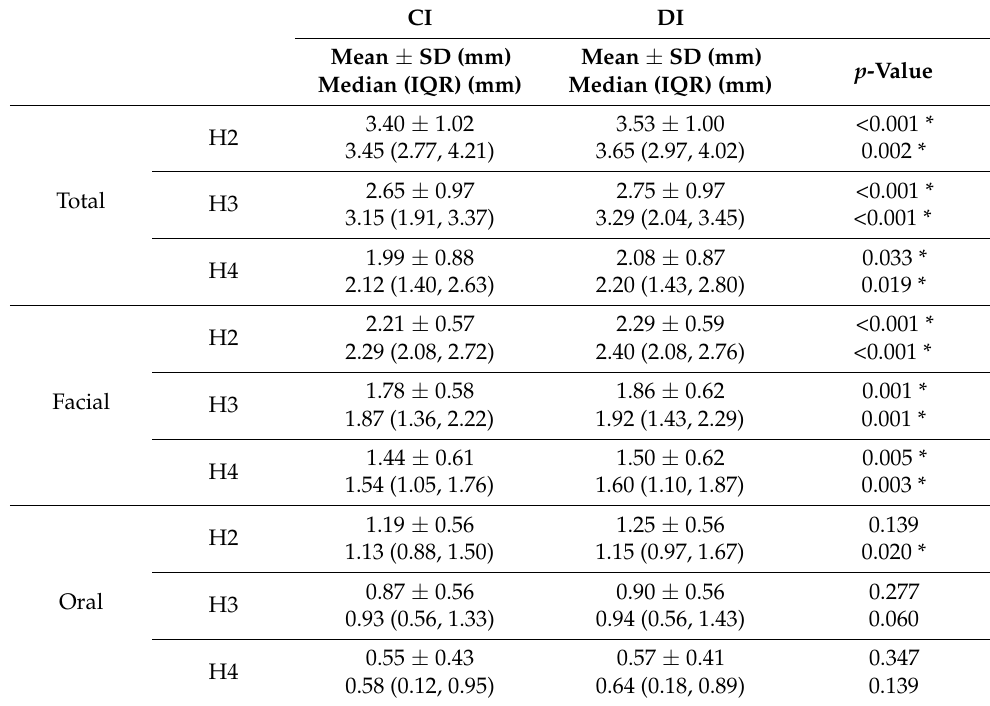
Table 1. Linear tissue changes over time according to the impression